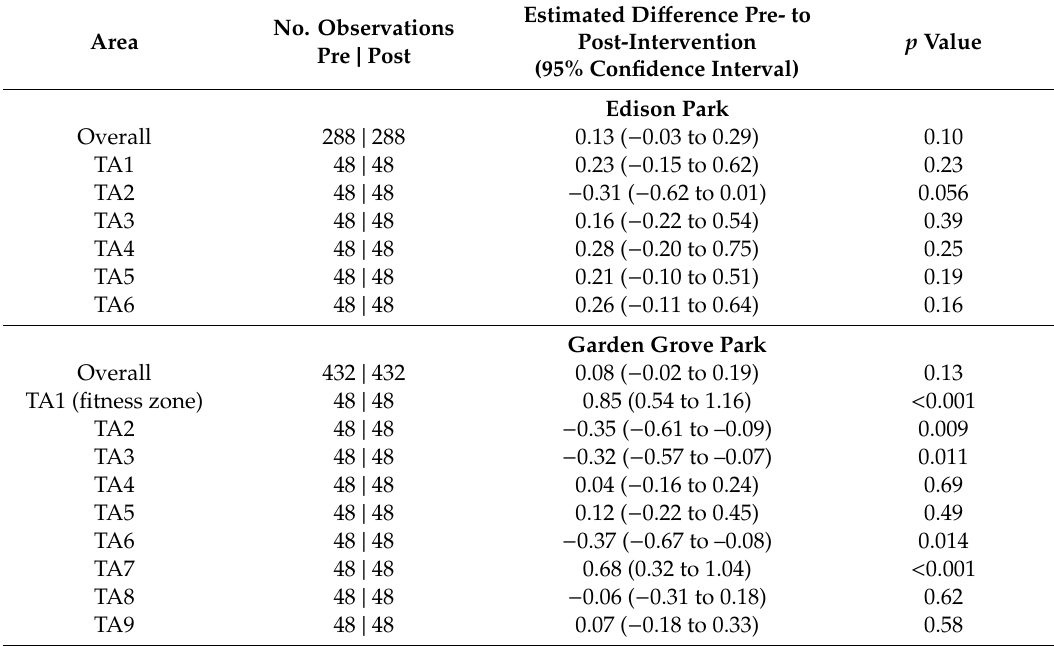
Table 3. Di ff erence in mean period-average Metabolic Equivalent of Task (MET) score comparing post- to